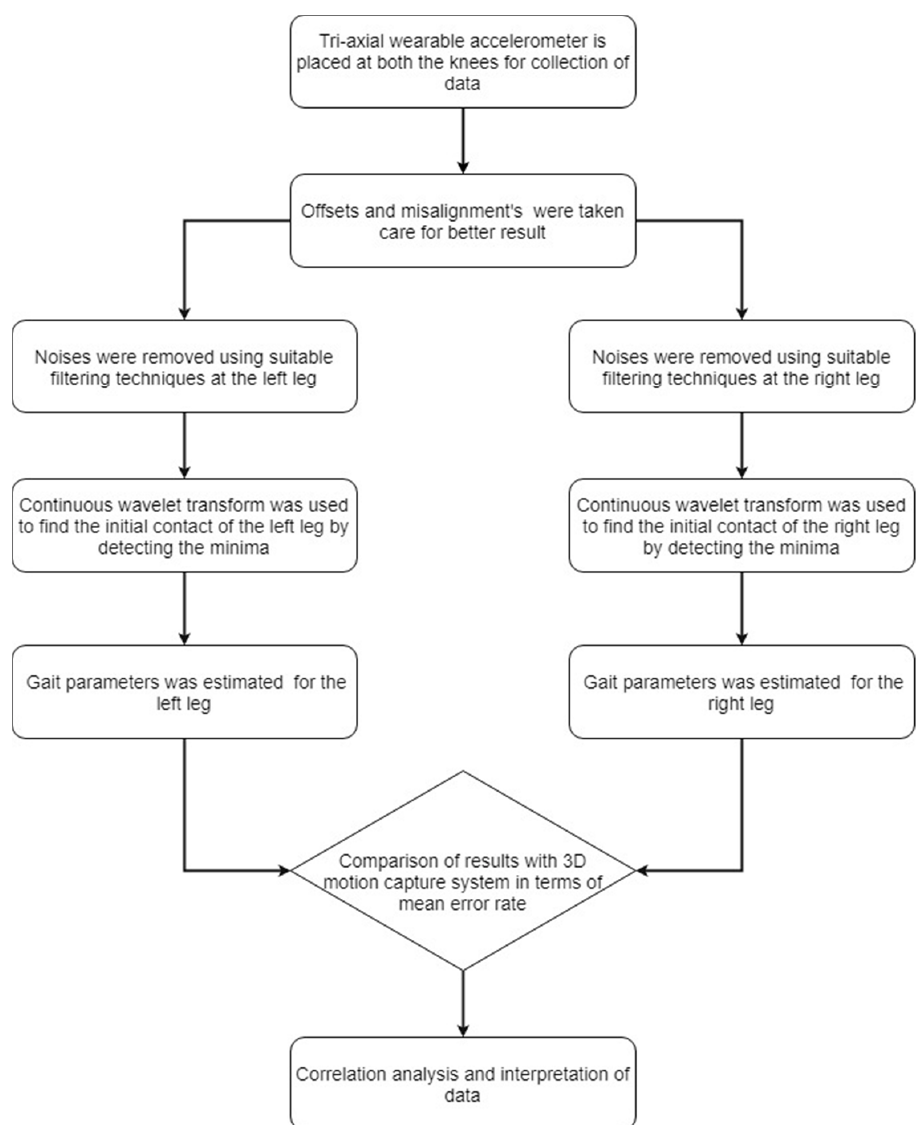
Figure 2. Flowchart for wearable based validation in FoG patients.